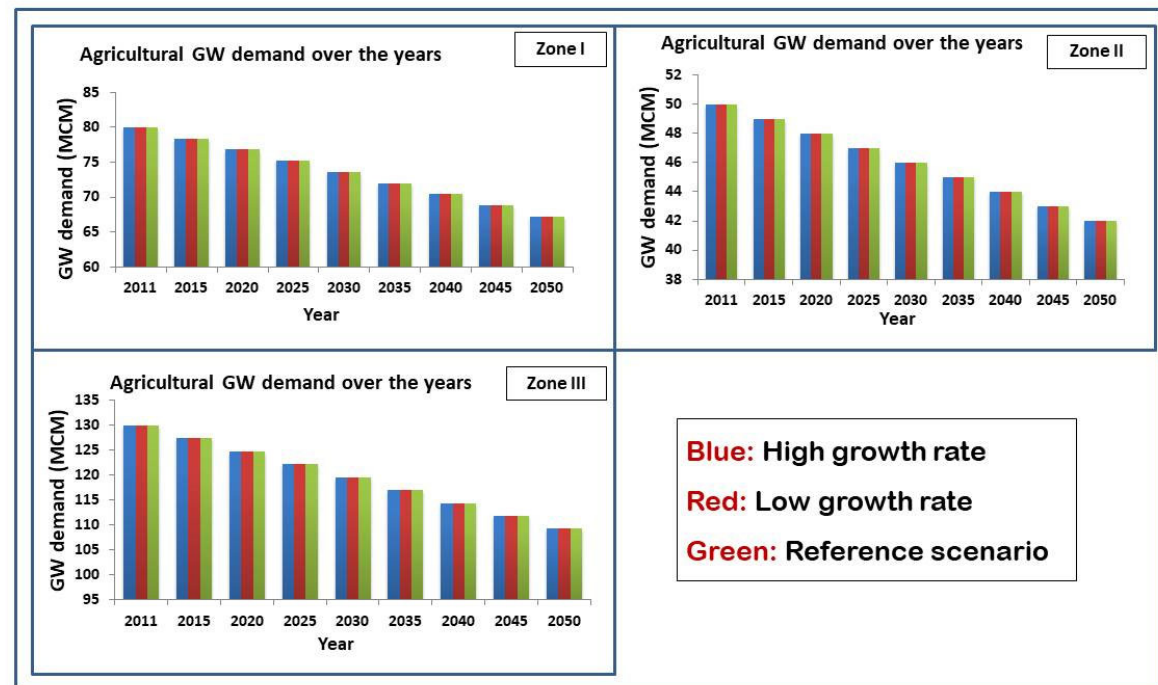
Figure 8. Agricultural groundwater demand under different scenarios.